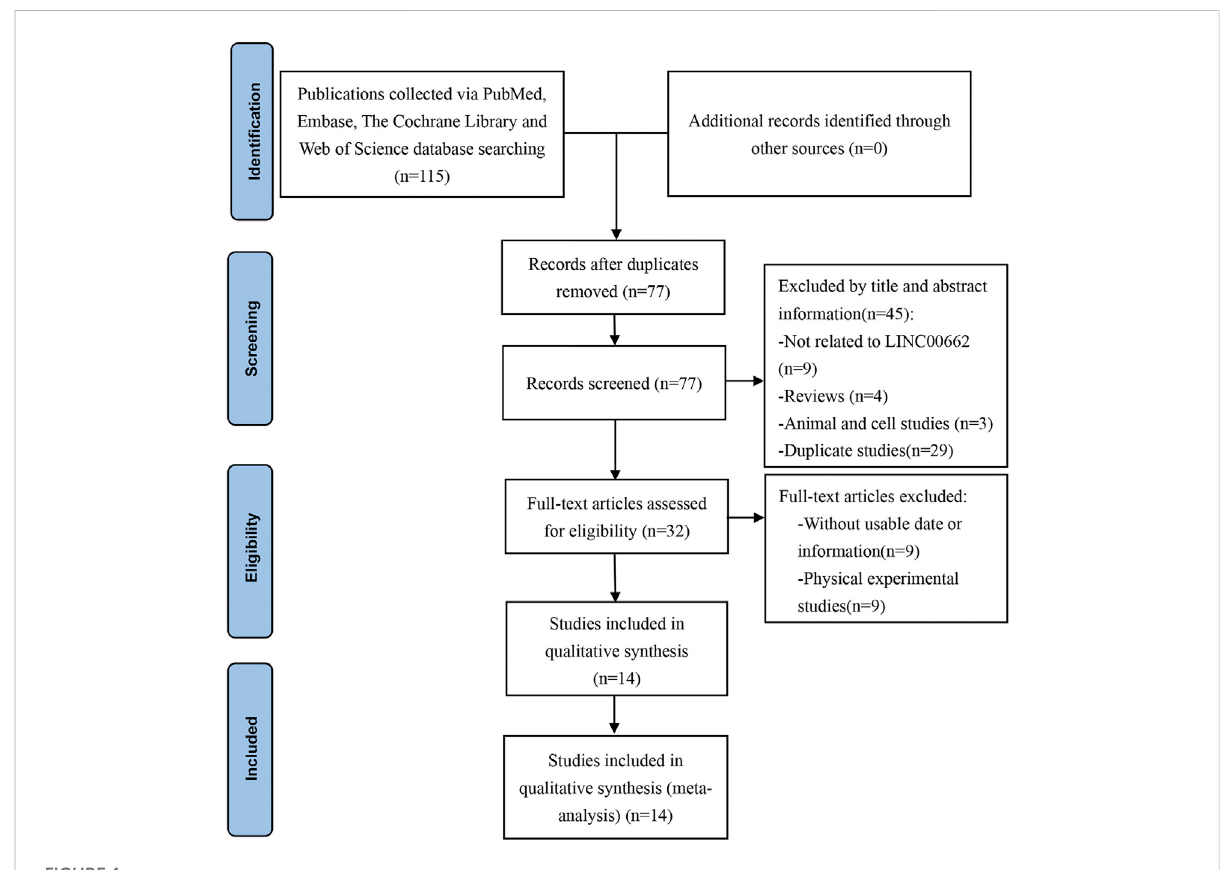
FIGURE 1 Flow diagram of this